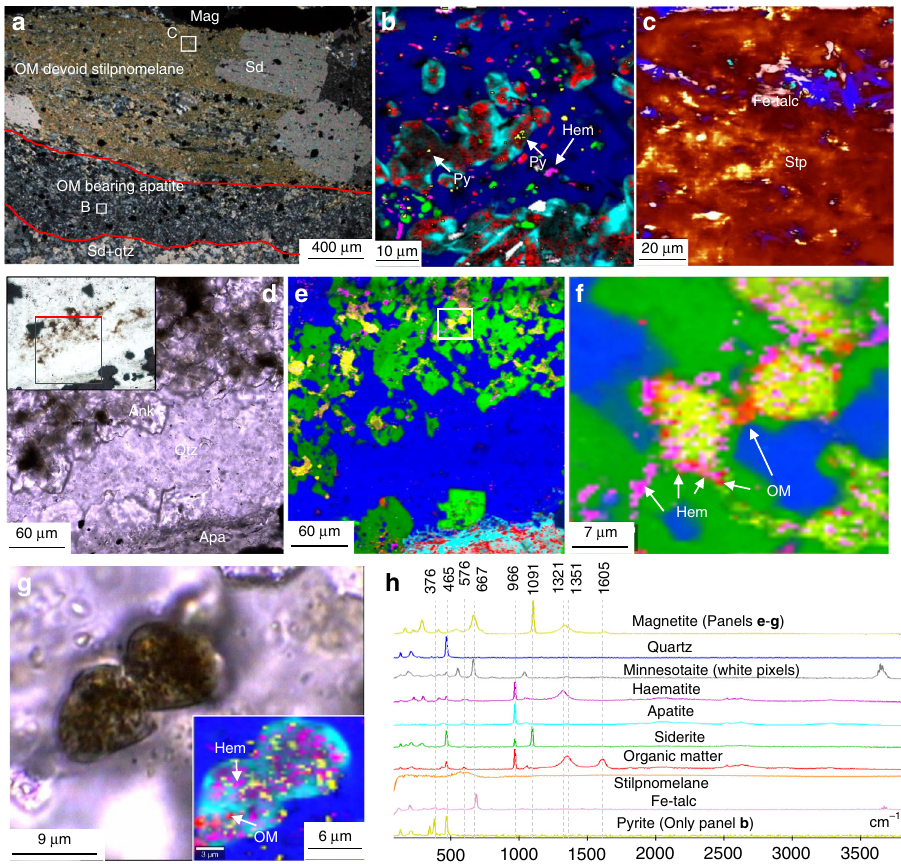
Fig. 5 Organic matter, apatite and carbonate layers in BIF. a CP image of a laminated OM-devoid Fe-silicate layer and OM-bearing apatite layer adjacent to a magnetite layer. b Raman image of the boxed area in a ; organic matter occurs within apatite, as does pyrite (white arrows). c Raman image of boxed area in a ; no organic matter was found within the stilpnomelane. The yellow colours are artefacts, no pyrite was identi fi ed in this scan area. d TL image of ankerite and apatite between magnetite bands. e Raman image of d , showing pockets of magnetite and haematite in ankerite. f Higher magni fi cation Raman image of the boxed area in e , showing the close spatial association of organic matter, haematite and magnetite within the ankerite. g TL image of an apatite grain with numerous inclusions, inset is a Raman image of the apatite, the inclusions are organic matter, haematite and magnetite. f Representative Raman spectra for this fi gure